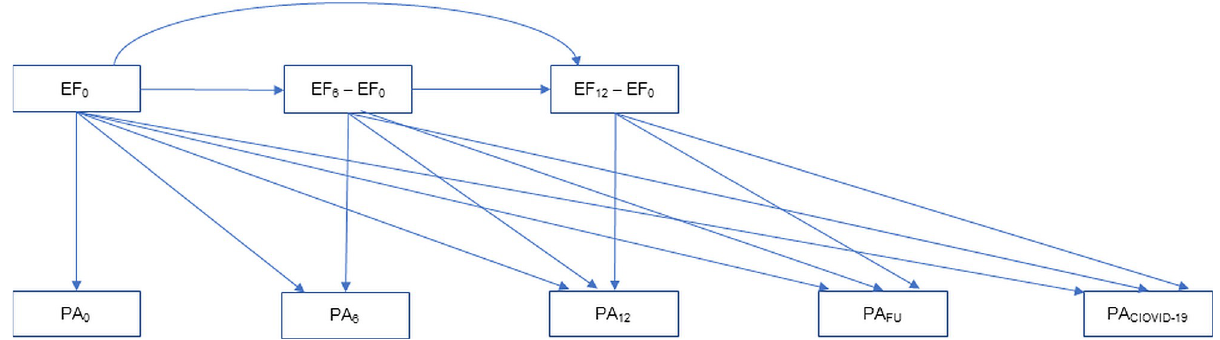
Fig 3. Change score model. Joint and separate change score models were created for the three executive function (EF) variables to assess the impact of changes in executive functions on concurrent and subsequent physical activity (PA) measurement (BL = baseline, 6m = six months, 12m = twelve months, FU = one year post-intervention